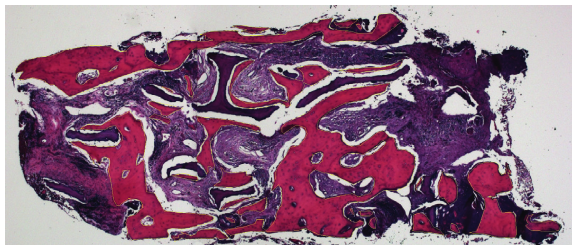
Figure 2: Histological image stained with hematoxylin and eosin showing the measured areas in the trephine, in